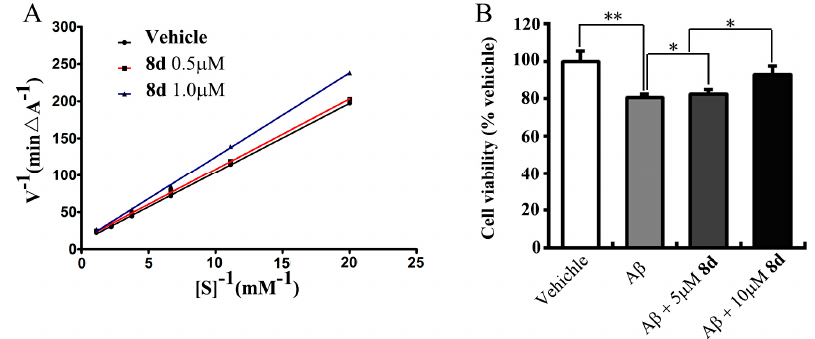
Figure 3. ( A ) Lineweaver–Burk plot for the inhibition of acetylcholinesterase by compound 8d ; ( B ) Effects of 8d against A β -induced neurotoxicity in Neuro-2A cells. Neuroprotective effect of 8d were evaluated by cells treated with 8d at the concentration of 0, 5 or 10 µ M in the presence of 10 µ M A β for 48 h; Vehicle group was treated with solvent. The cell viability was assessed using the 3-[4,5-dimethylthylthiazol-2-yl]-2,5 diphenyltetrazoliumbromide (MTT) assay. Data are from three independent experiments and are expressed as the mean ± SD values. ** p < 0.01 compared to vehicle. * p < 0.05, represents significant differences from the control group.